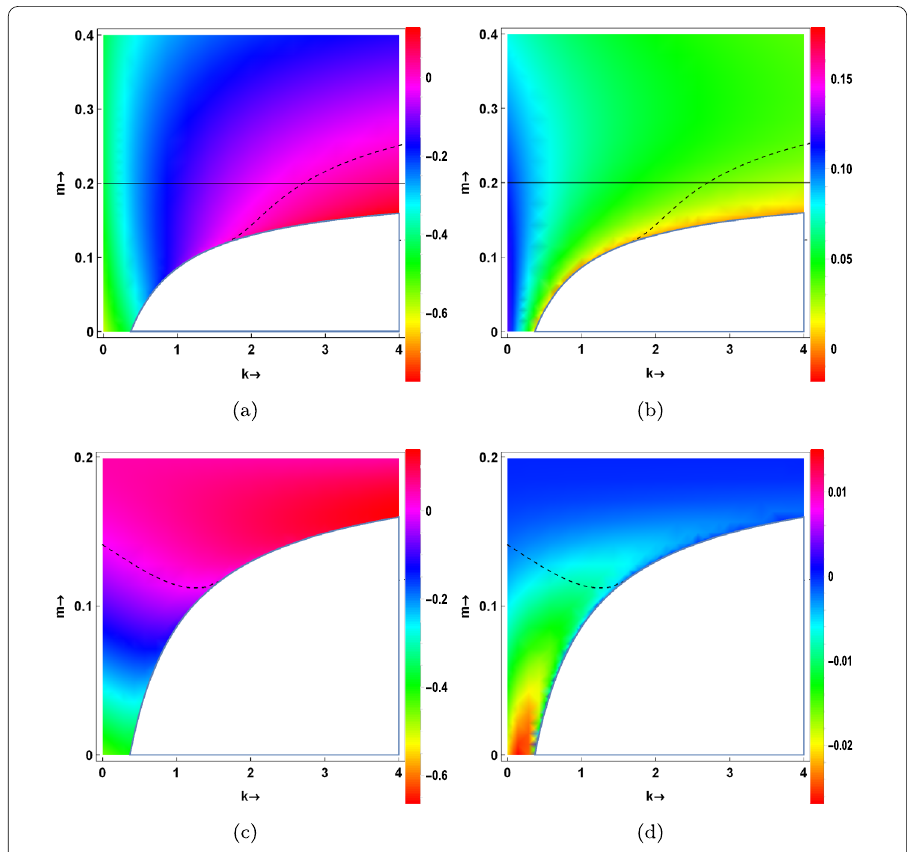
Figure 9 For system (2.4a)–(2.4b), black dashed lines represent trace value is zero, ( a ) Trace values for E 2 , which changes from negative to positive. ( b ) Determinant values for E 2 , which is always positive. ( c ) Trace values for E 3 , which changes from negative to positive. ( d ) Determinant values for E 3 , which is always negative. Also, confirms the results in Fig. 3